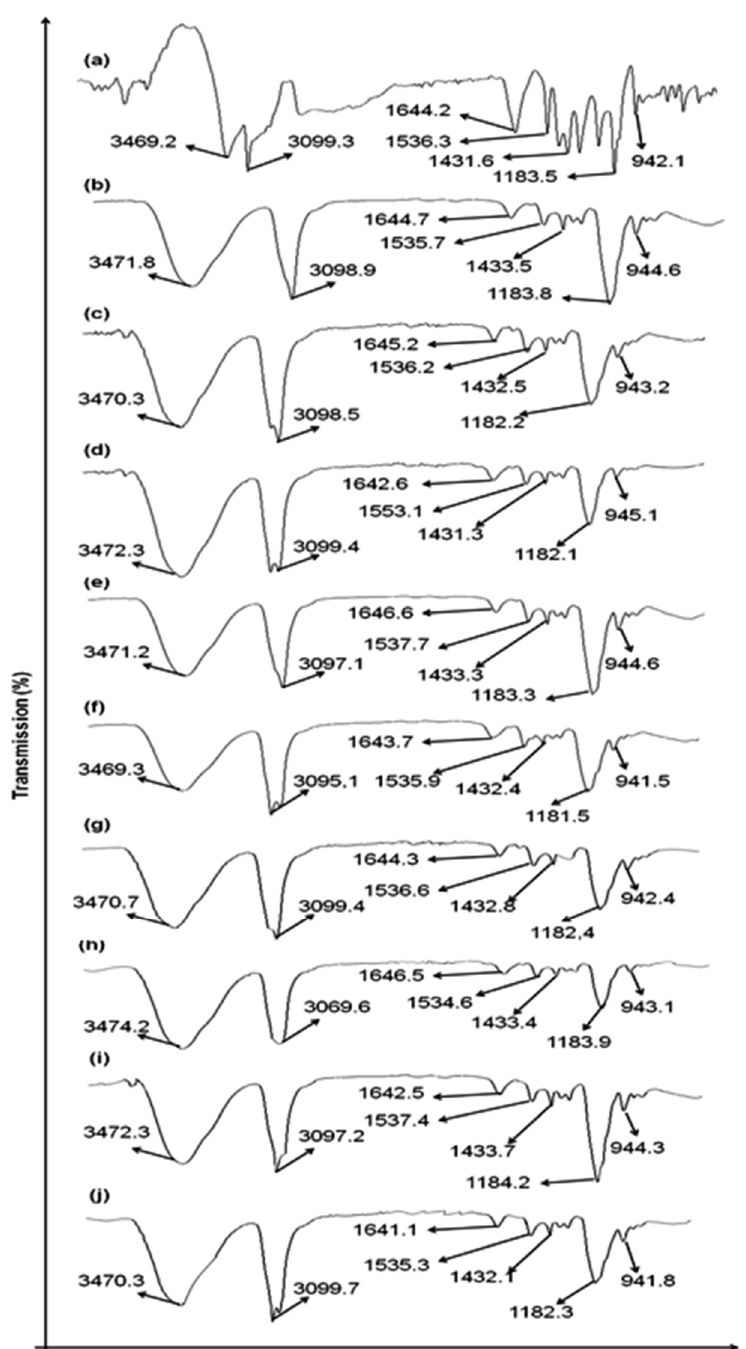
Figure 1. ATR-FTIR spectra of ( a ) pure drug methotrexate, ( b ) F1, ( c ) F2, ( d ) F3, ( e ) F4, ( f ) F5, ( g ) F6, ( h ) F7, ( i ) F8, and ( j ) F9.